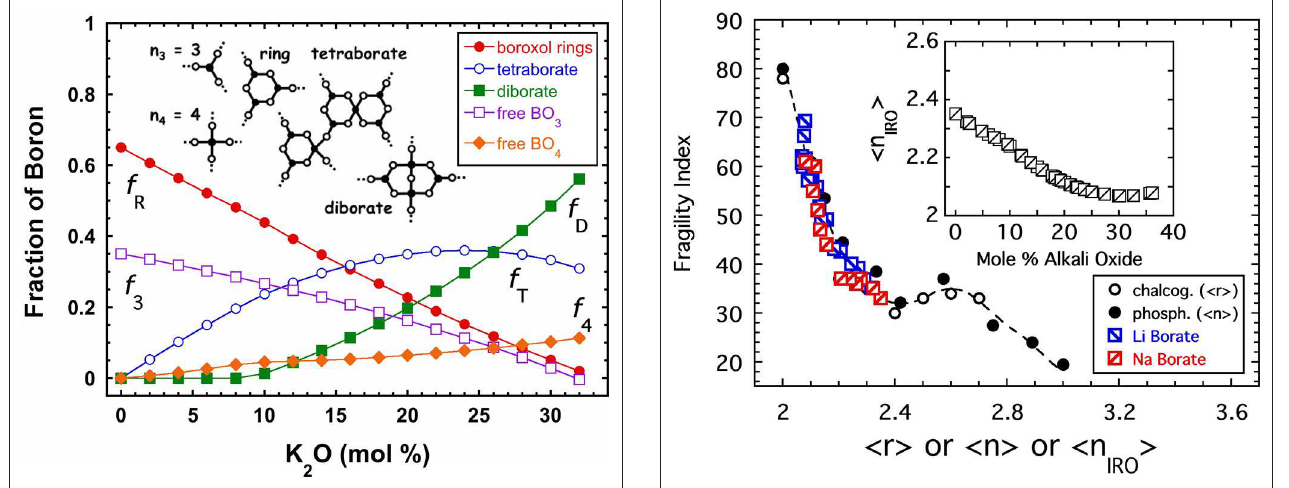
FIGURE 6 | The fraction of boron atoms in various structural units in potassium borate glasses. Values are derived from an NMR investigation (Youngman and Zwanziger, 1996 ) and include five basic configurations illustrated as cartoons in the figure. These include free boron units of either 3 or 4 coordination as well as boroxol rings, diborate, and tetraborate structures discussed in the text.